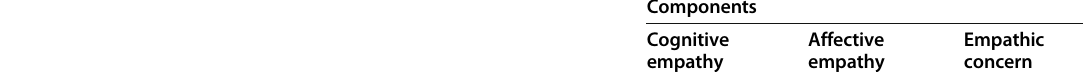
Table 2 Standardised factors of the empathy questionnaire